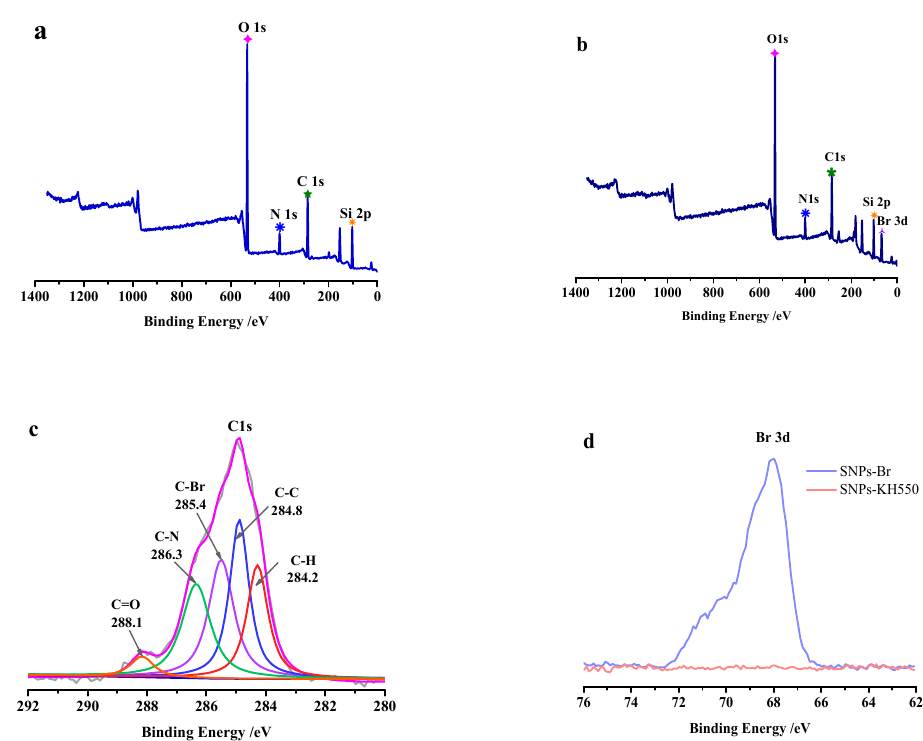
Figure 3. XPS spectra of SNPs-KH550 ( a ), and SNPs-Br ( b – d ): Survey scan curves range from 0 to 1400 eV ( b ), the C1s core-level spectra ( c ) and Br3d region ( d ).